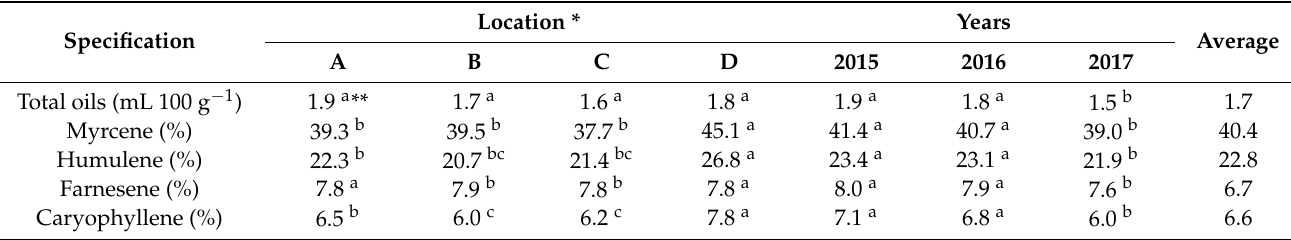
Table 14. The content of essential oils in total and the share of myrcene, humulene, farnesene and caryophyllene in hop cones depending on the location and years (Mean for varieties).